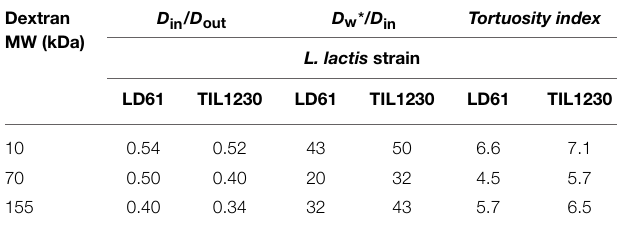
TABLE 3 | Calculated ratios of effective diffusion coefficients of dextrans obtained inside and outside L. lactis colonies ( D in / D out ), of diffusion coefficients of dextrans in water * vs. inside colonies ( D w / D in ), and corresponding tortuosity indices, calculated as square root of D w / D in . Dextran D in / D out MW (kDa)